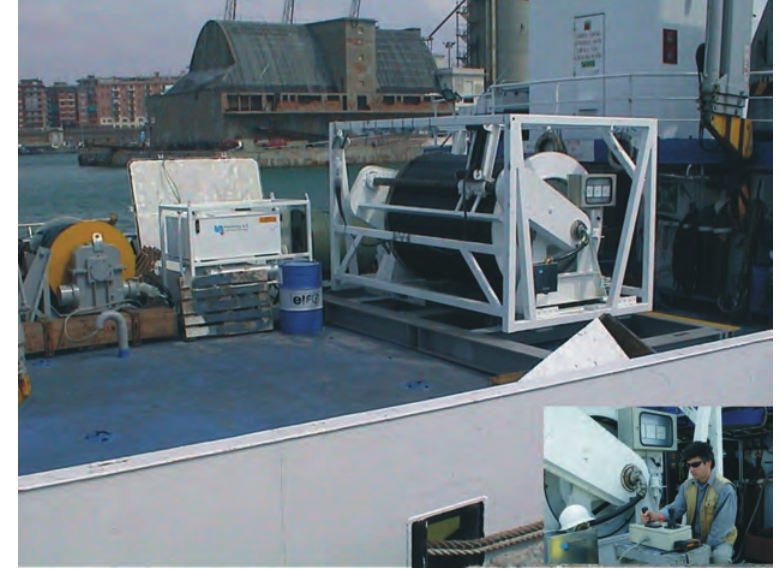
Fig. 4. The GEOSTAR handling system: power unit ( right ), cable spooled on the winch ( left ) and system con- sole (insert) .